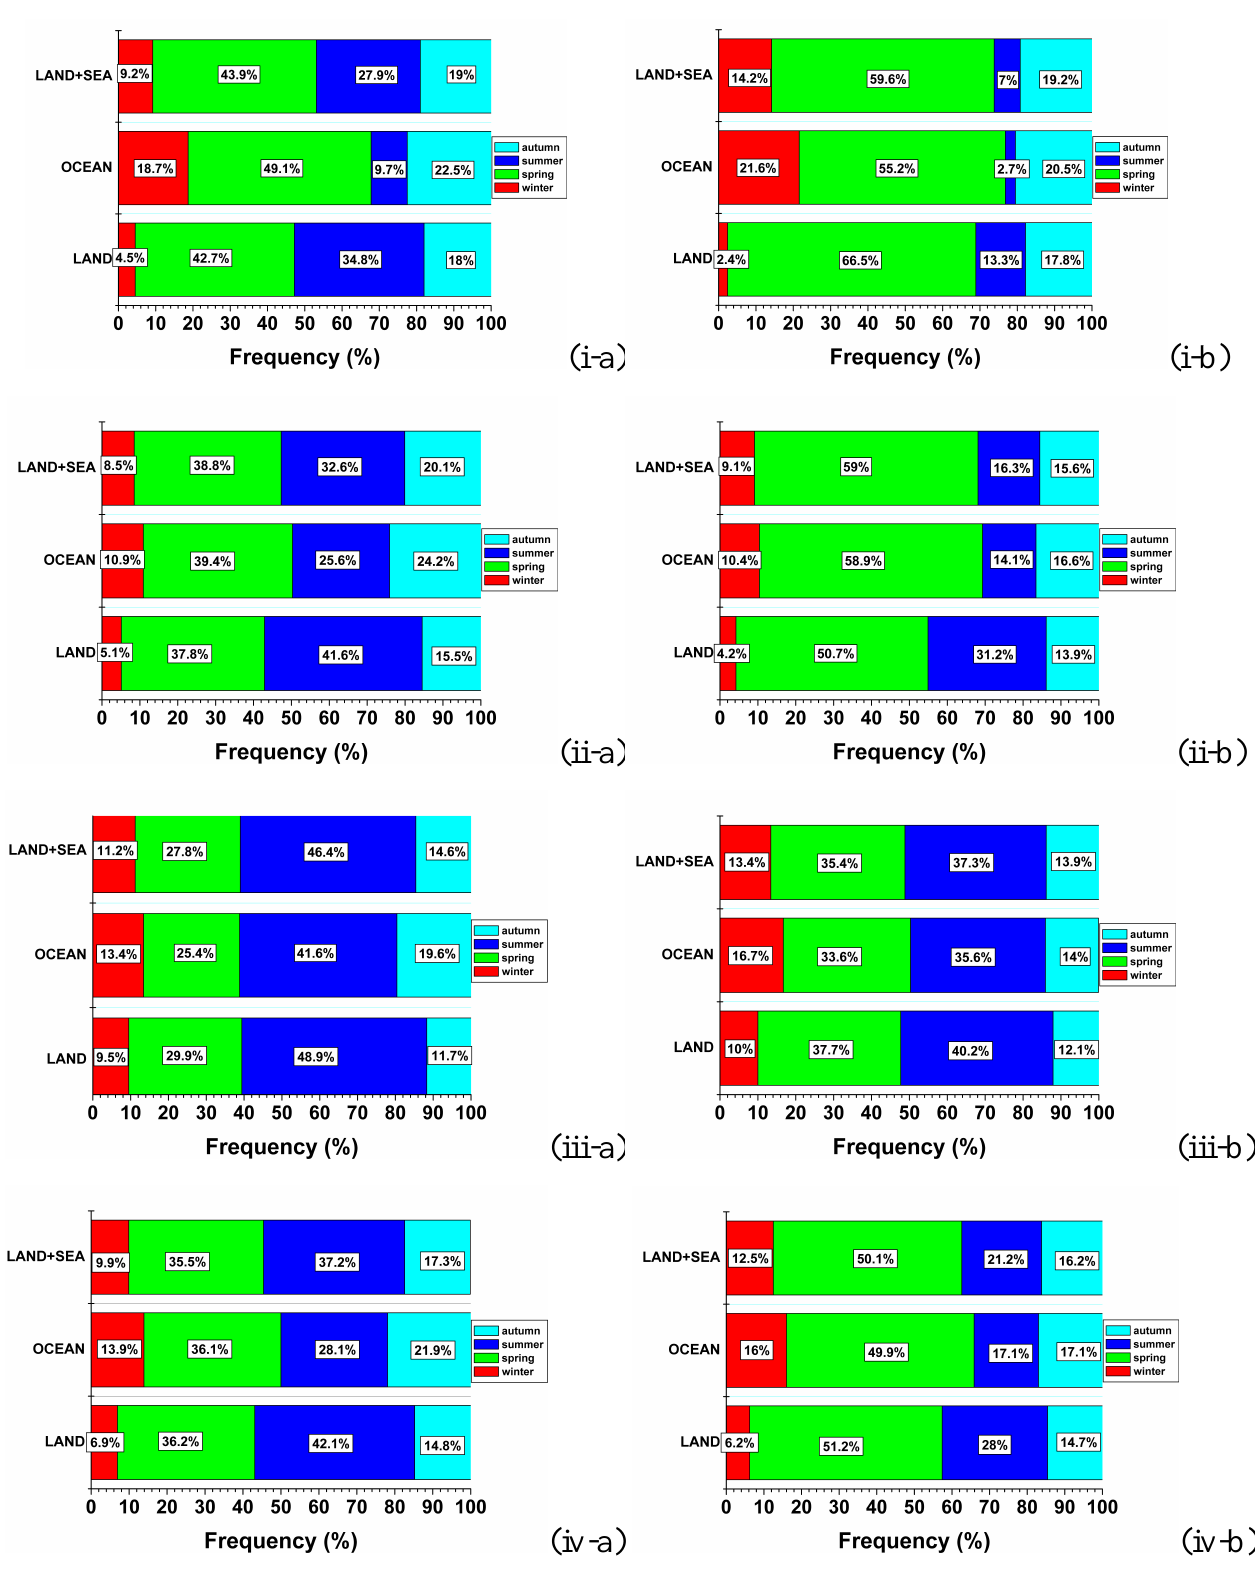
Fig. 6. Seasonal distribution of the frequency of (a) strong and (b) extreme aerosol episodes over land, sea, and land+sea areas in the (i) eastern, (ii) central, (iii) western and (iv) whole Mediterranean basin during the period 2000-2007.